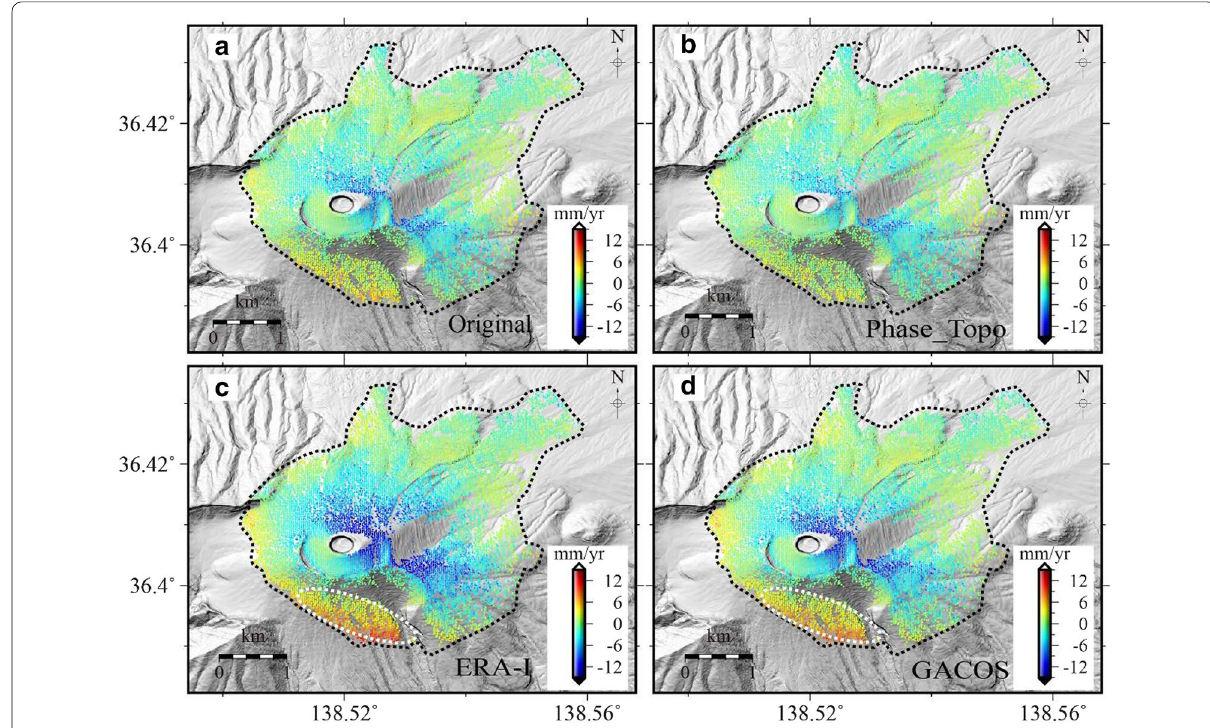
Fig. 6 Comparisons of mean velocities from ascending Sentinel-1 (path 39) before and after the tropospheric delay correction. a Mean LOS velocities without correction; b , c mean velocities corrected for tropospheric delay by b the elevation-phase linear fitting method, c the ERA-I weather model, and d the GACOS weather model. The white dashed polygons in c and d indicate the regions showing significant LOS shortening after the